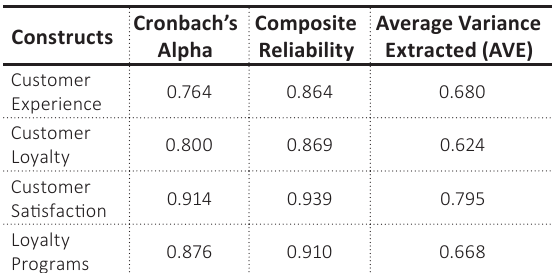
Table 2. Cronbach’s alpha, composite reliability, and average variance extracted